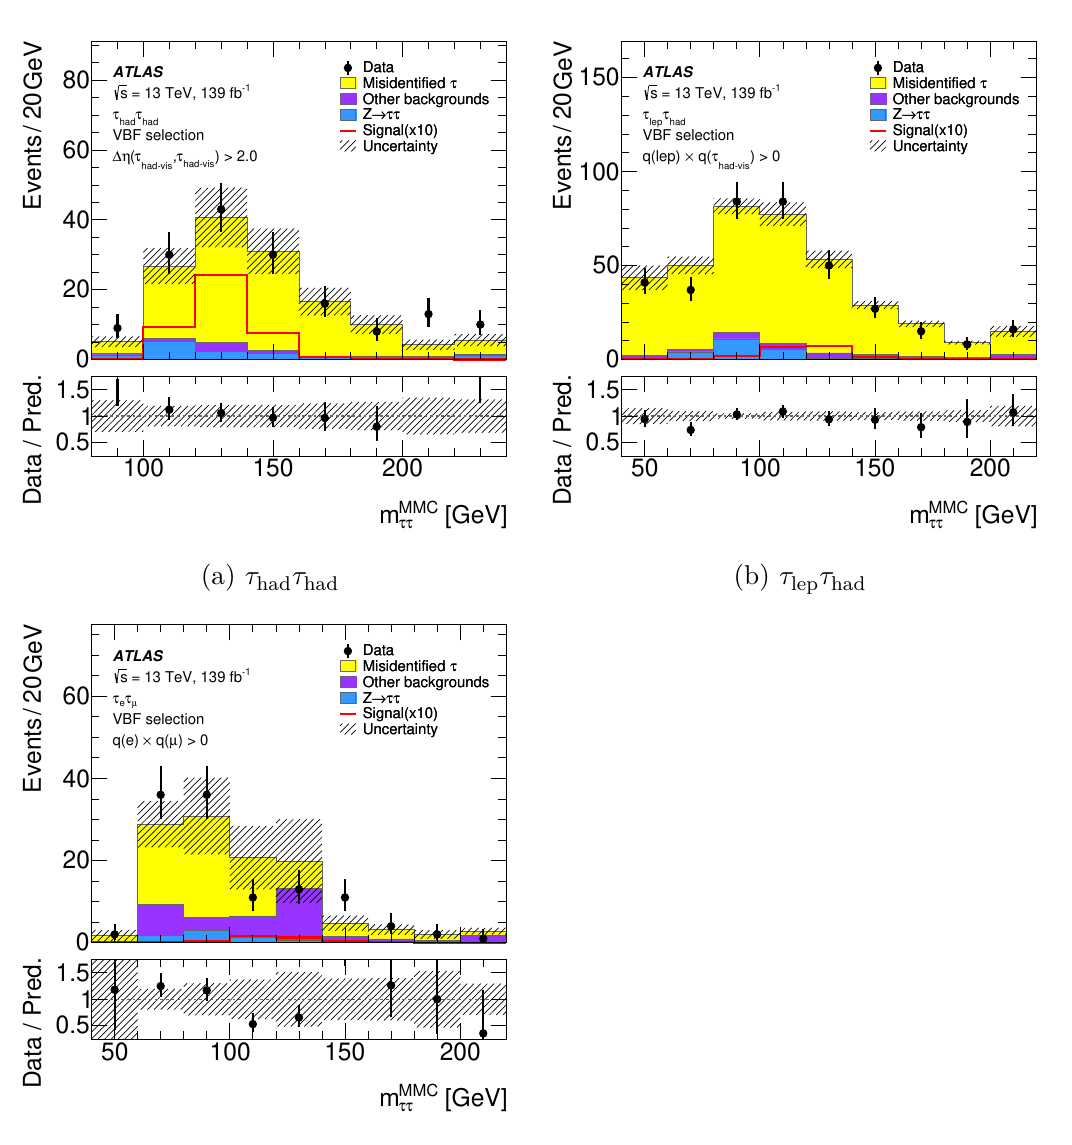
Figure 6. Validation of the data-driven estimate of the processes with jets misidentified as τ the VBF categories: (a) events with ∆ η ( τ with a light lepton and τ charge leptons in the τ the limited size of the simulated samples and the systematic uncertainty of the data-driven